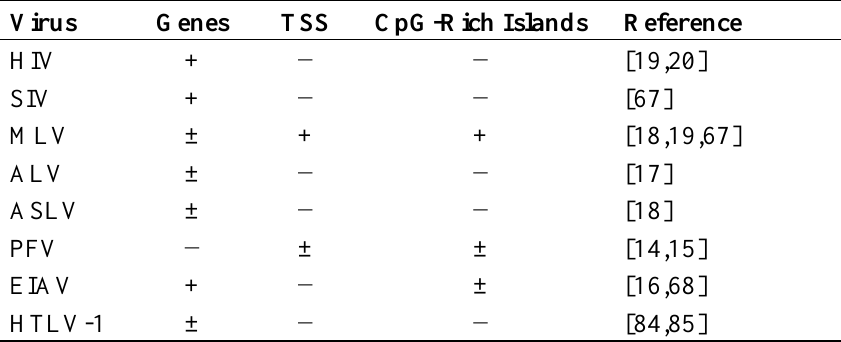
Table 1. Integration pattern of different retroviral